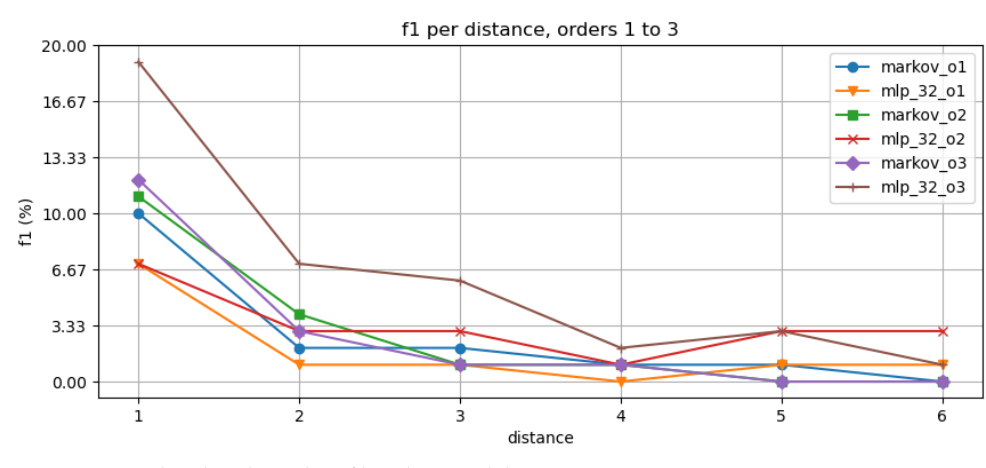
Figure 4. F1 related to the order of baseline models.